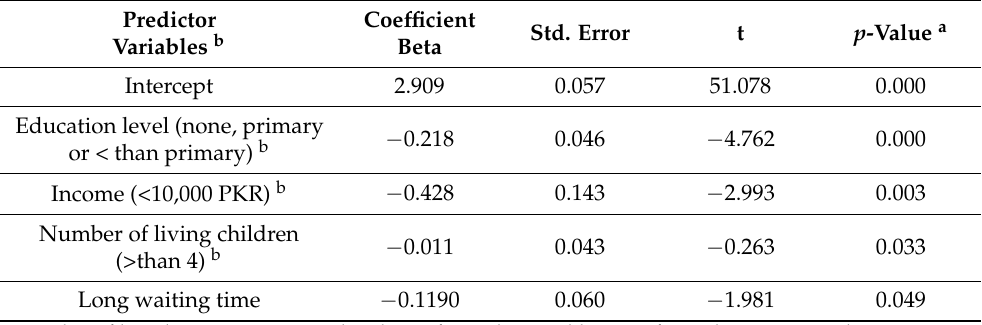
Table 4. Multiple linear regression showing variables that influence the total quality of prenatal care as perceived by expectant